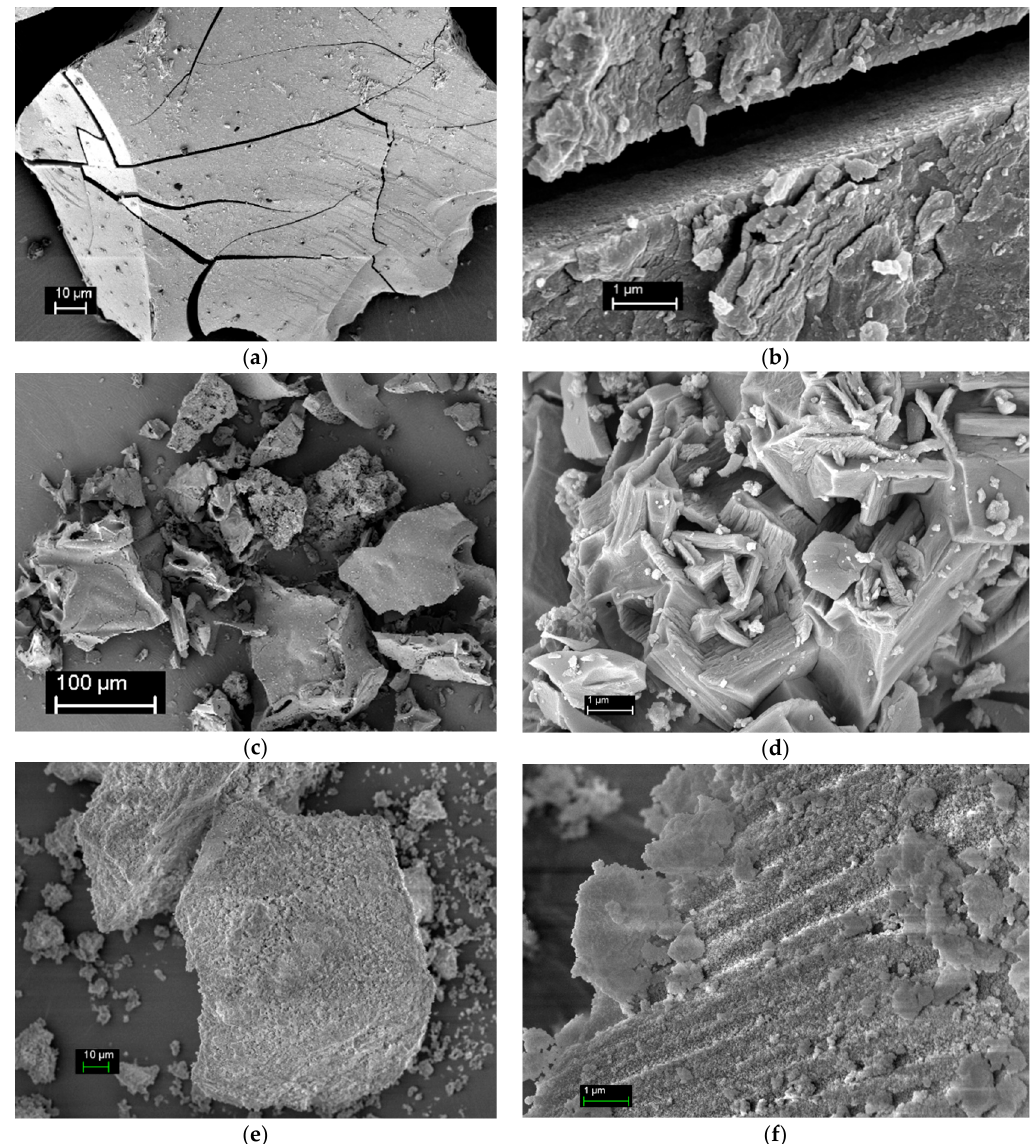
Figure 3. Scanning electron microscopy (SEM) images of external and internal surface of samples S1 ( a , b ), S2 ( c , d ), S3 ( e , f ).